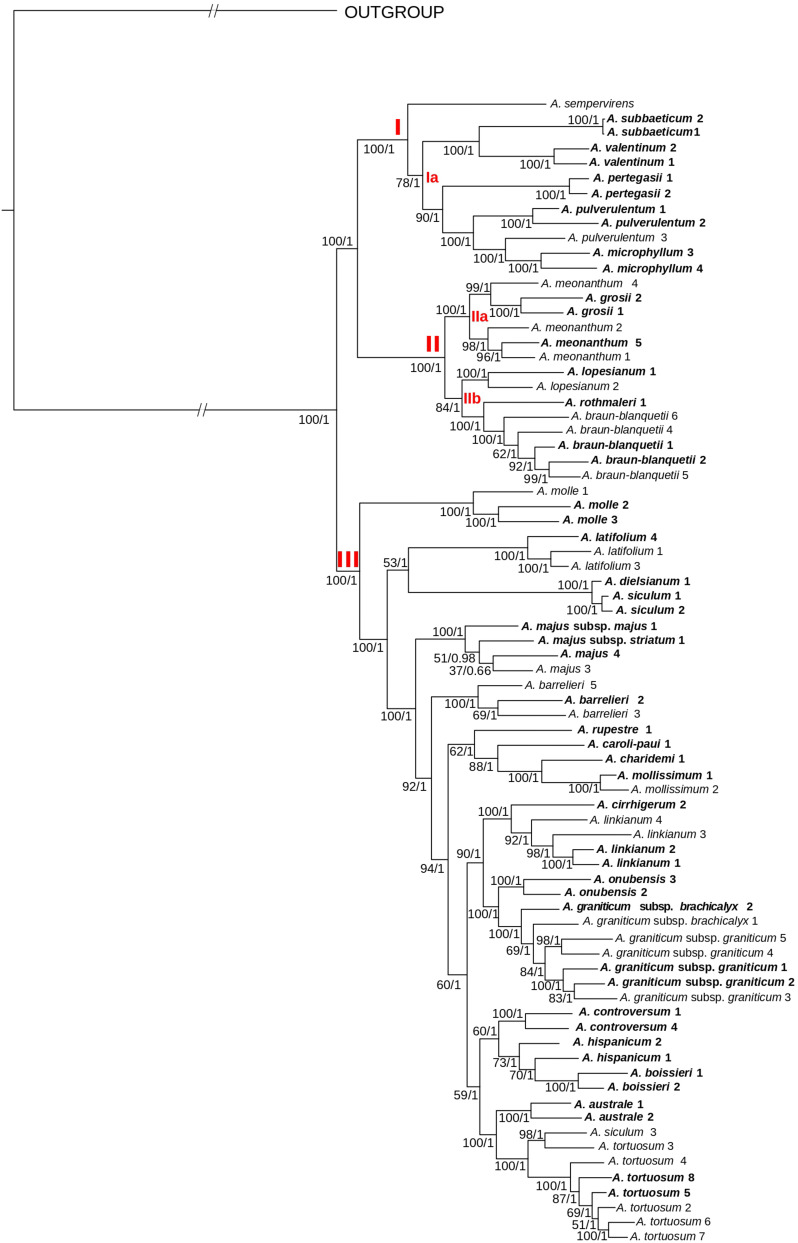
Phylogenetic reconstruction of Antirrhinum based on concatenated DNA sequences of 4,663 genotyping-by-sequencing loci (c90m6 dataset) obtained from a wide sample of specimens representing the geographic distribution of species. The best scoring of the maximum likelihood tree from RAxML analysis is shown. Three major clades (I–III) and subclades (Ia, IIa, and IIb) are indicated in red letters. Values at branches are bootstrap support values from the maximum likelihood (RaxML) analysis followed by posterior probabilities from the Bayesian (ExaBayes) analysis. In bold, populations collected from topotypic localities, i.e., those where the type material was collected. Further voucher information for each specimen (indicated with name and numbers) is detailed in Supplementary Table 1 of the Supplementary Files.